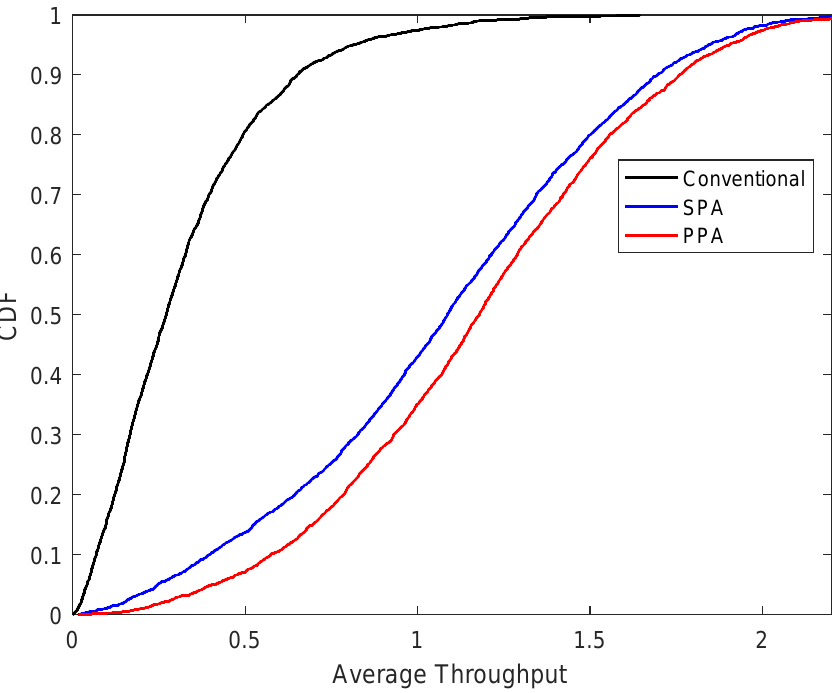
Figure 11. CDF of the average uplink rate per user when M = 64 using an MRC detector.